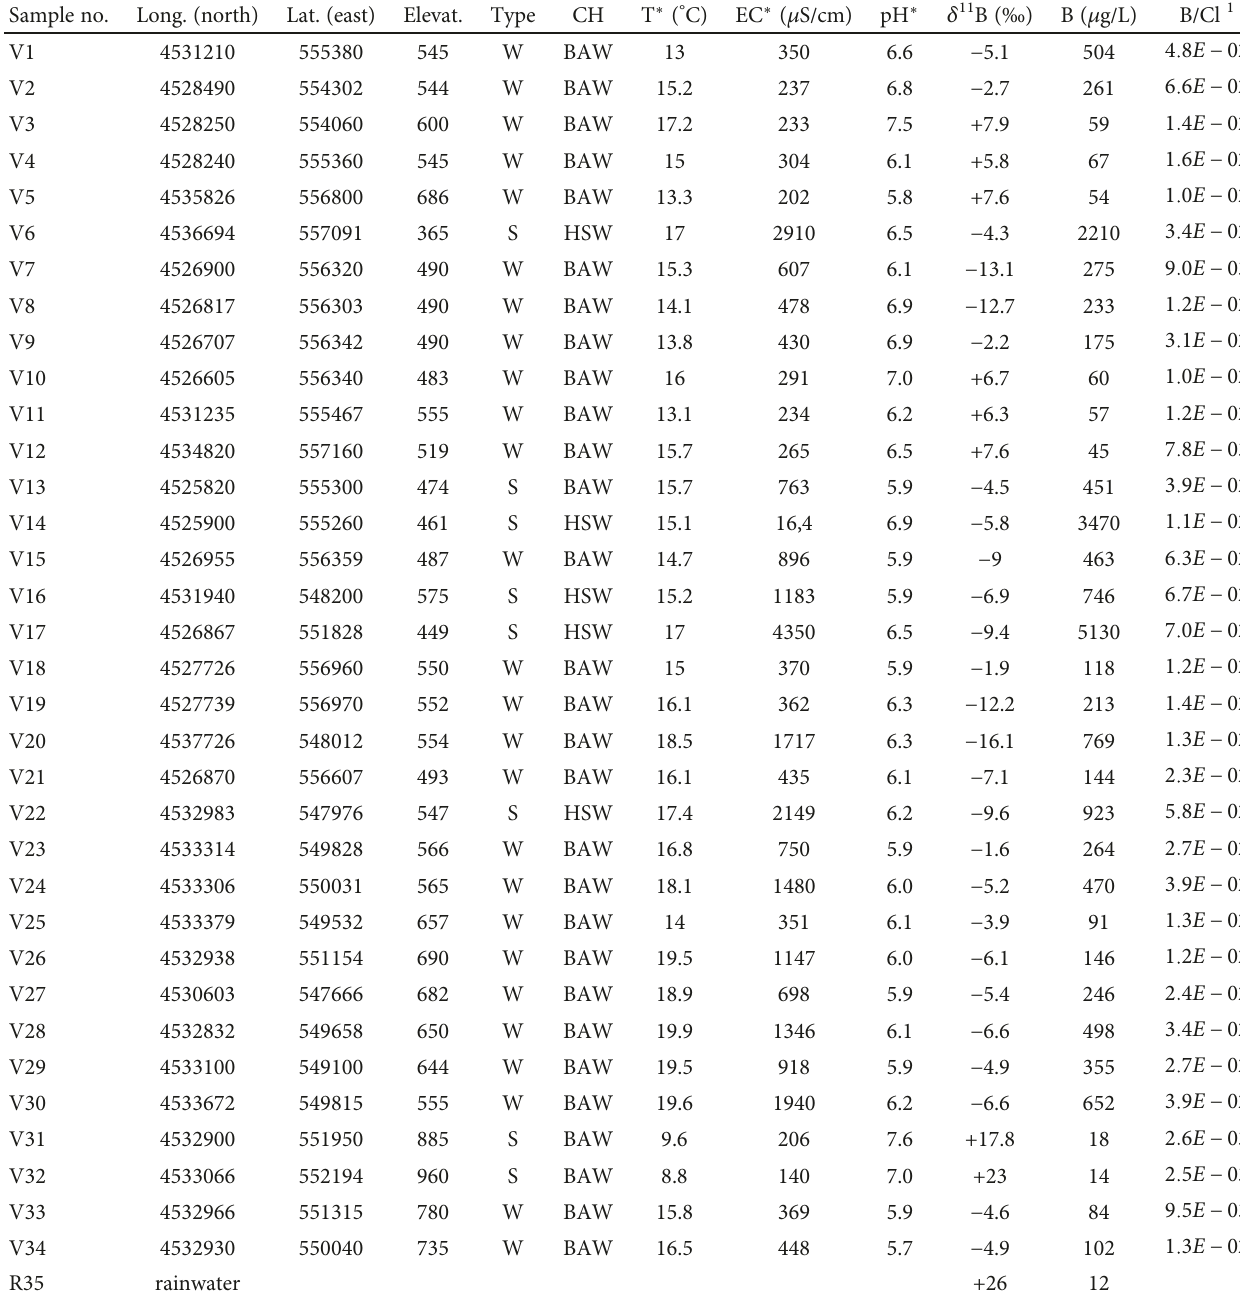
Table 1: B concentration and isotopic composition of the Mt. Vulture groundwaters. Sample no. Long.